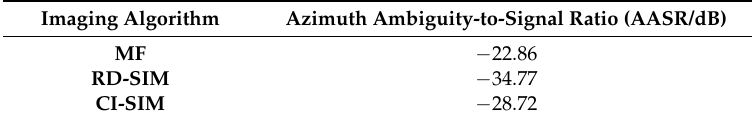
Table 4. The azimuth ambiguity-to-signal ratio (AASR) of the target via three